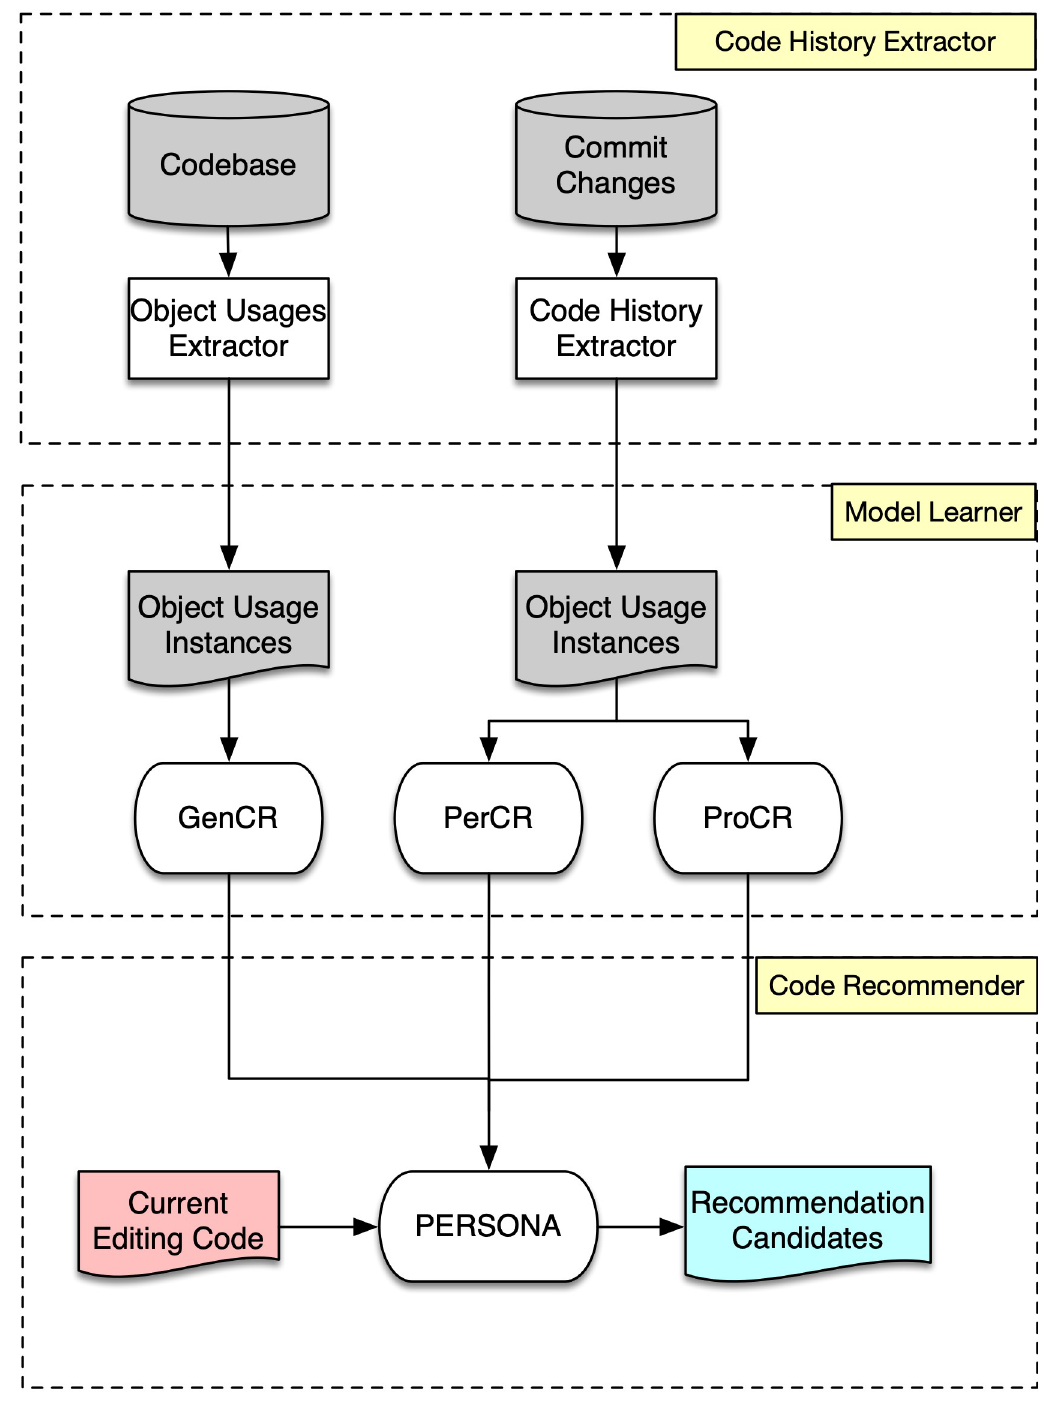
Fig 2. Overview of the system.